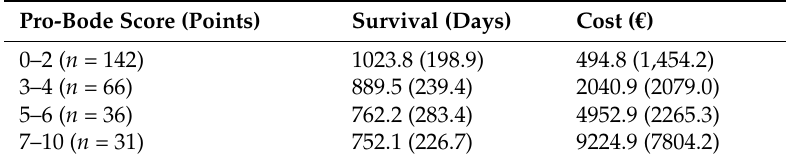
Figure 3. The increasing rate of costs by the PRO-BODE score. Table 2. The inverse relation between the cost of COPD and the patients’ survival according to the PRO-BODE score.